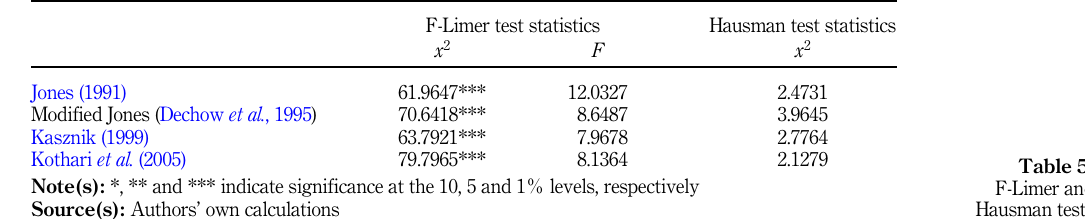
Table 4. Kao cointegration test